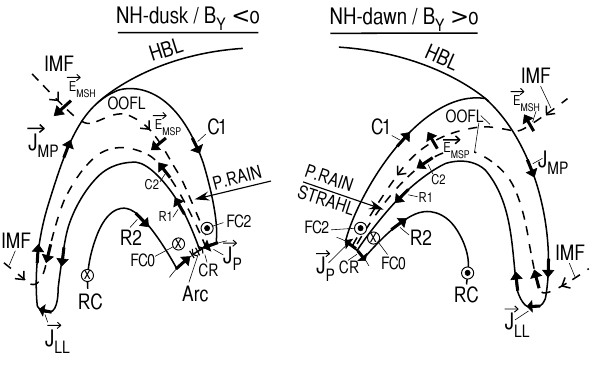
Fig. 28. Schematic illustration of flow channel FC 2, ionospheric Pedersen current ( J P ), Birkeland currents C1, C2, R1, R2, polar rain (P.RAIN) precipitation (with and without the “strahl” com- ponent) and the outer magnetosphere with LLBL current ( J LL ), high-latitude boundary layer (HBL), and the magnetopause current ( J MP ) in the Northern Hemisphere (NH). Currents and E -fields are marked by bold arrows. The NH-dusk/ B y < 0 and NH-dawn/ B y > 0 cases are shown in the left and right sections, respectively. The IMF, “old open magnetic field lines” (OOFL) and the E -field coupling from the magnetosheath ( E MSH ) to the magnetosphere ( E MSP ) are also indicated. Current R2 is connected to the magnetospheric ring current (RC). Not to